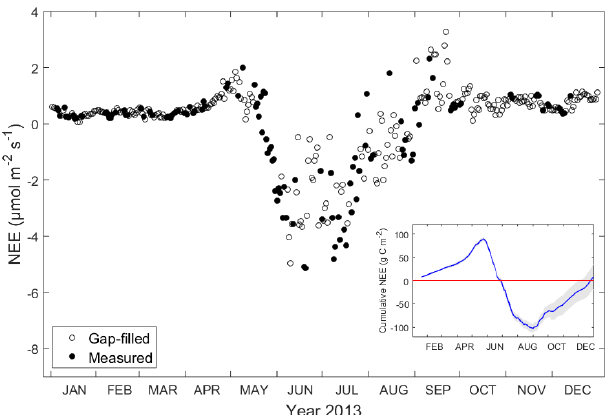
Figure 3. Daily average of net ecosystem exchange of CO 2 (NEE, µmolm − 2 s − 1 ) in 2013. Filled dots indicate measurement (when available half-hourly measurement data ≥ 10) and circles indi- cate gap-filled data (when available half-hourly measurement data < 10). The insert shows cumulative NEE (gCm − 2 ) in the ecosys- tem and the red line indicates the zero reference line. Error bounds (marked in grey) on cumulative NEE reflect the 95% confidence interval for the gap-filling procedure.